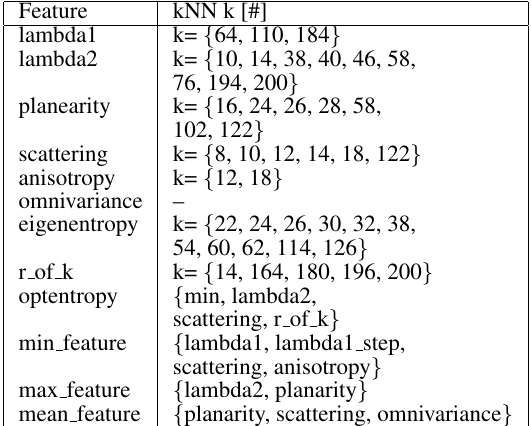
Figure 7. Overall Accuracy - Ball-shaped